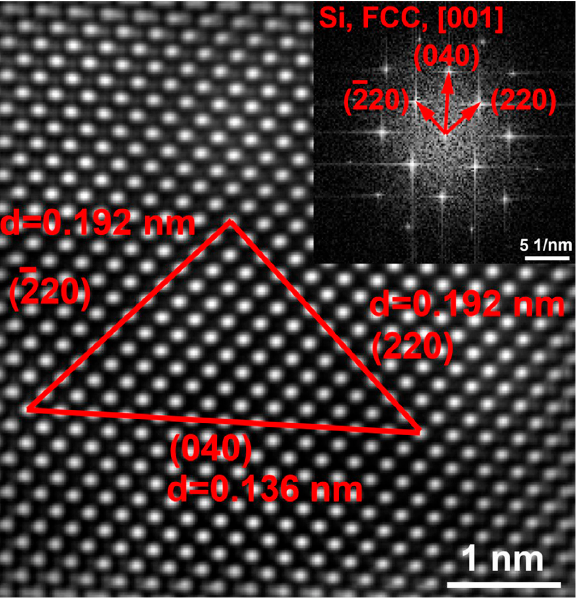
Figure 1. HRTEM image of [001] ZA of the pristine Si. The inset is the corresponding FFT image.